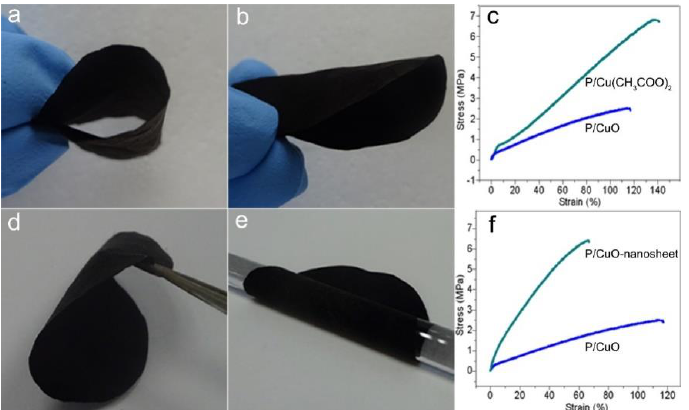
Figure 5. The optical image of P/CuO-nanosheet membrane with alterable shape ( a , b , d , e ); ( c , f ), the mechanical properties of P/Cu(CH 3 COO) 2 , P/CuO membranes, and P/CuO-nanosheet membranes.